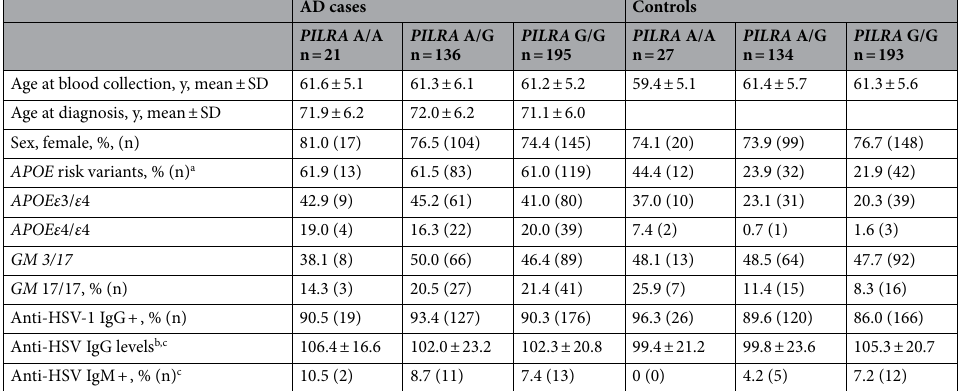
Table 4. Descriptive statistics of PILRA R78G-A carriers and non-carriers stratified by case–control status. AD Alzheimer’s disease, y years, SD Standard deviation, n number, APOE apolipoprotein E. a Genotype ε3/ε4 or ε4/ε4. b Expressed in arbitrary units. c Among anti-HSV-1 IgG seropositive subjects).